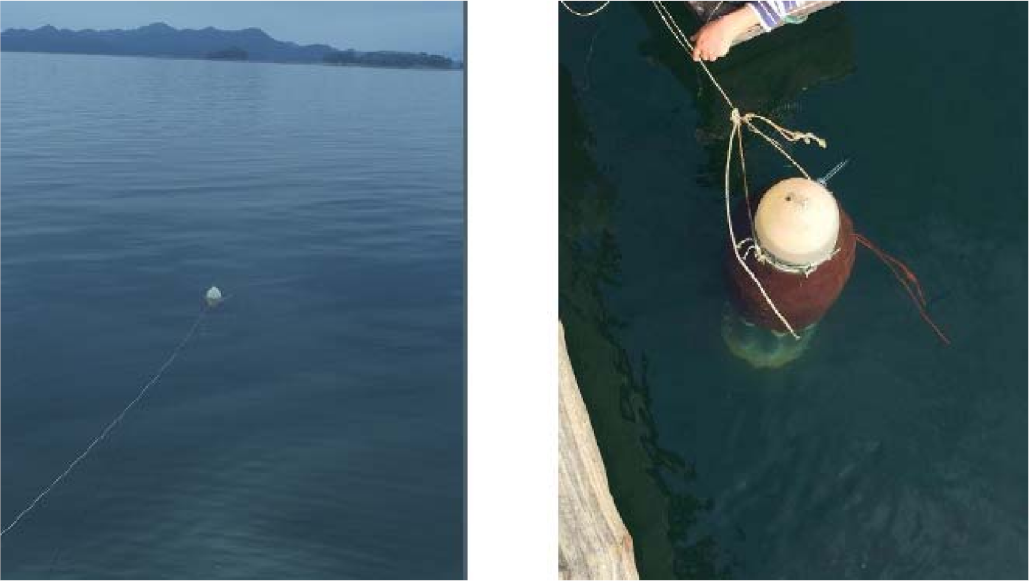
Figure 7. Photos of lake